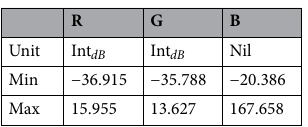
0 values in different bands.